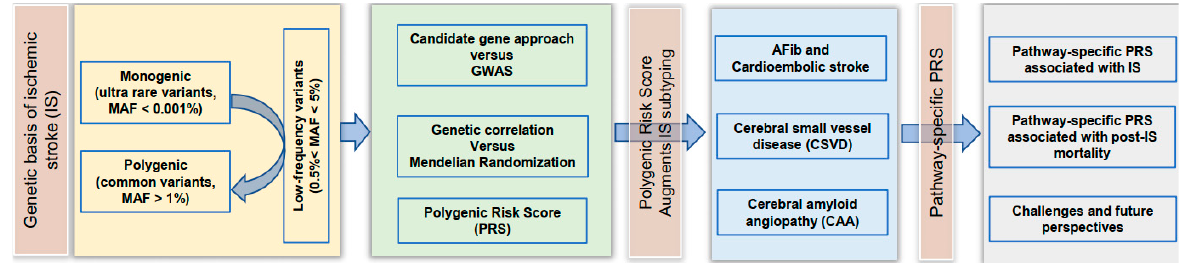
Figure 1. Flow chart summarizing the topics discussed in this review